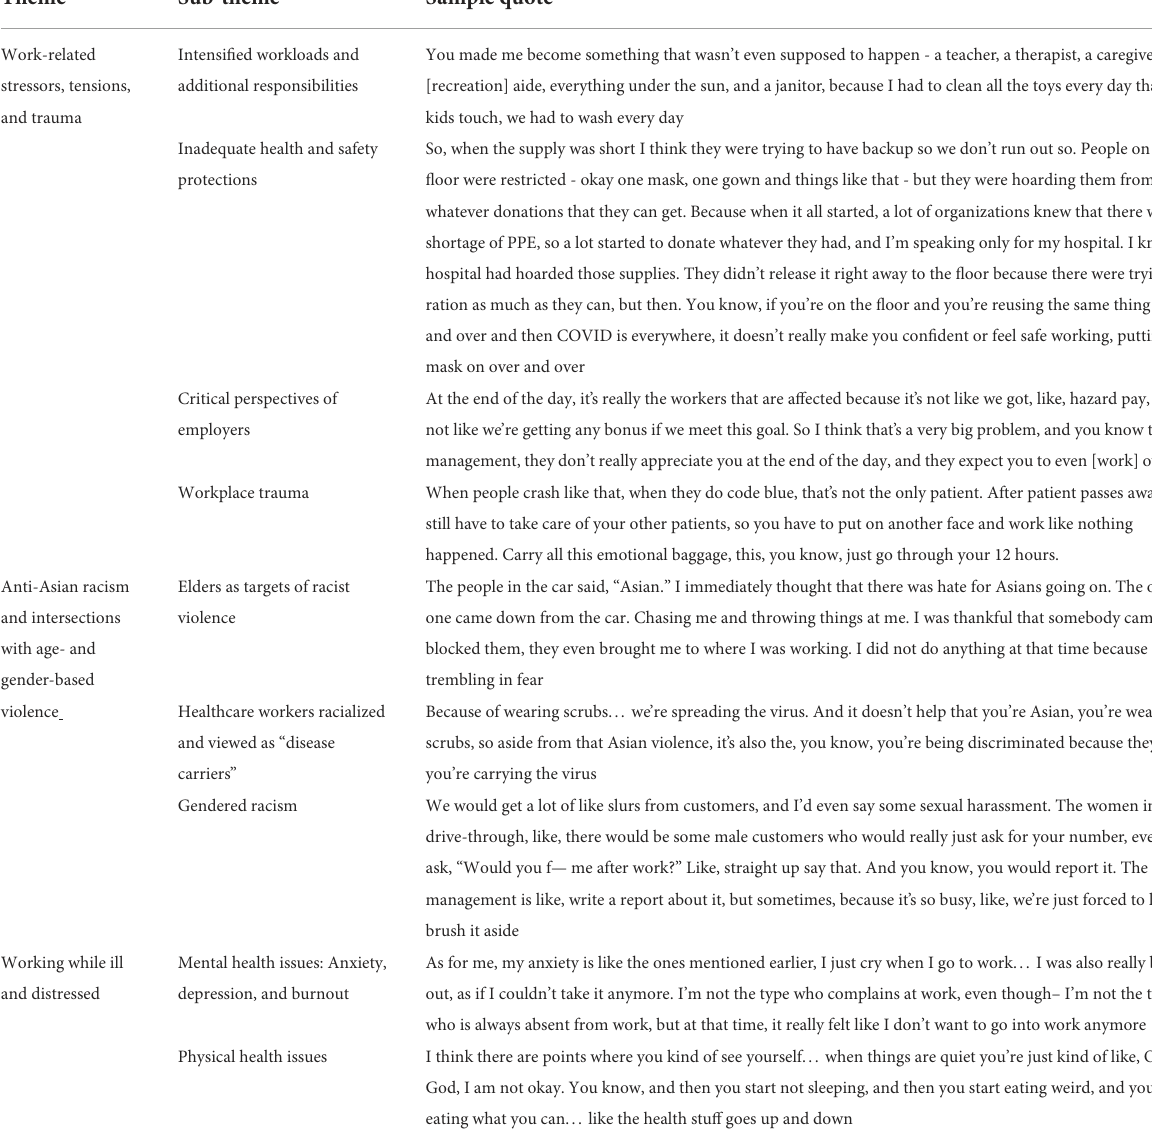
TABLE 2 Thematic